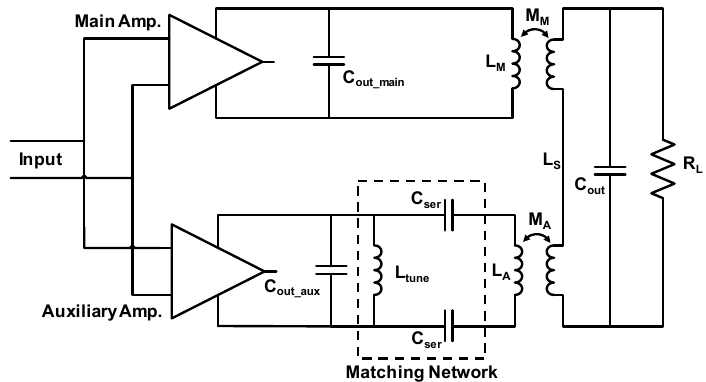
Figure 11. Schematic of an mm-wave Doherty power amplifier with additional asymmetrical transformer matching circuit at the auxiliary side for efficiency enhancement [99].